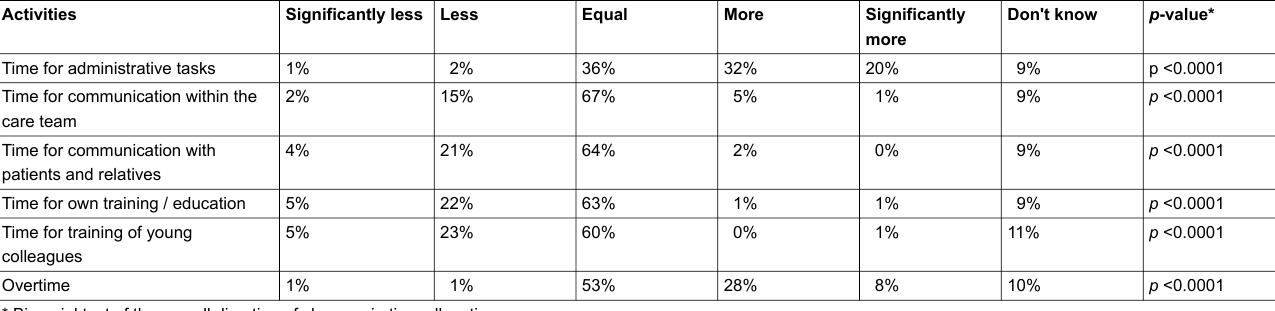
Table 2: Changes in working time allocation for certain activities since the introduction of SwissDRG in 2012 (n = 382).